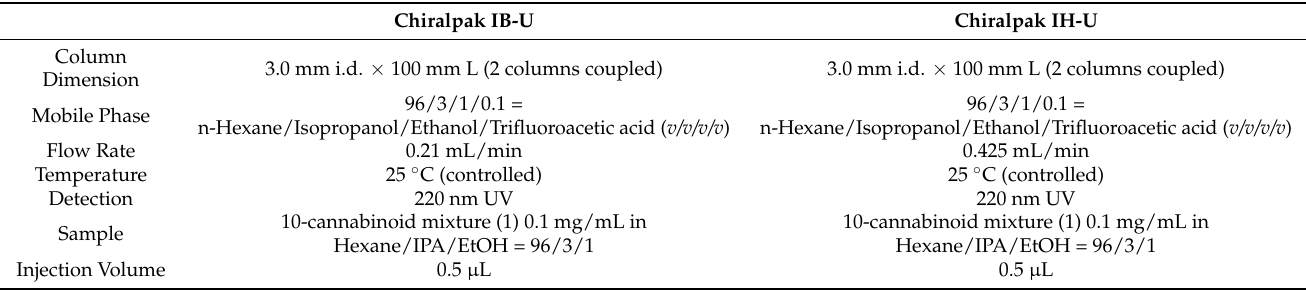
Table 1. Summary of normal-phase analysis